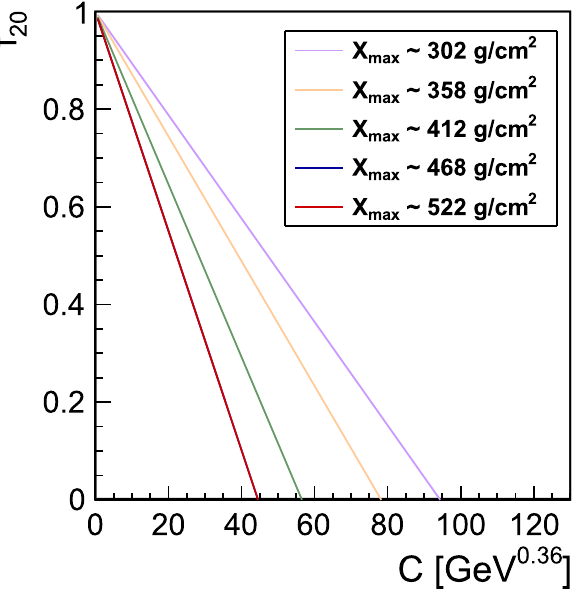
Fig. 12 Calibration lines ( f 20 , C ) for several ranges of X max and with S em ∼ 200 GeV